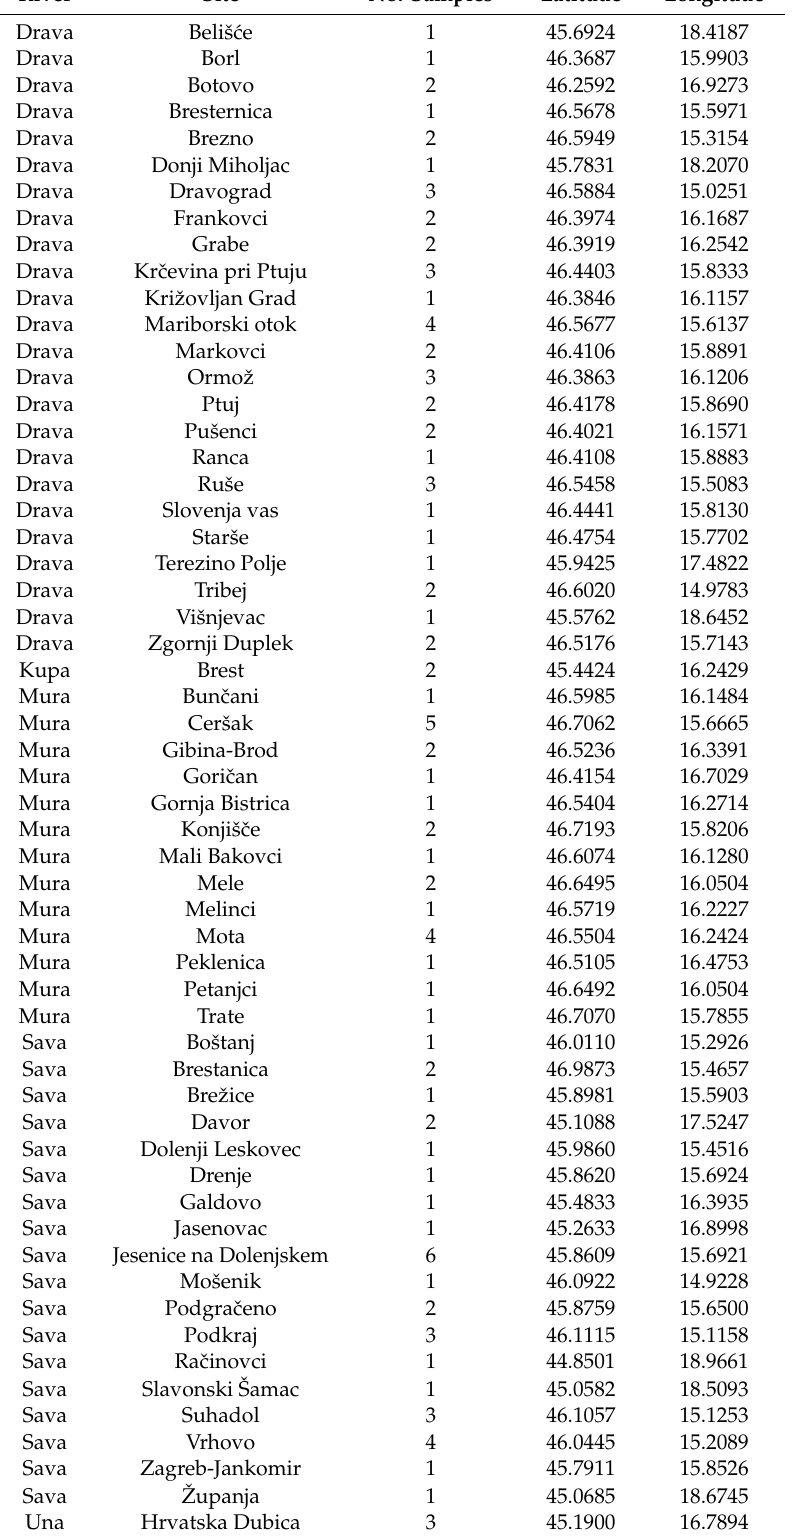
Table A1. List of Sampling sites and number of collected